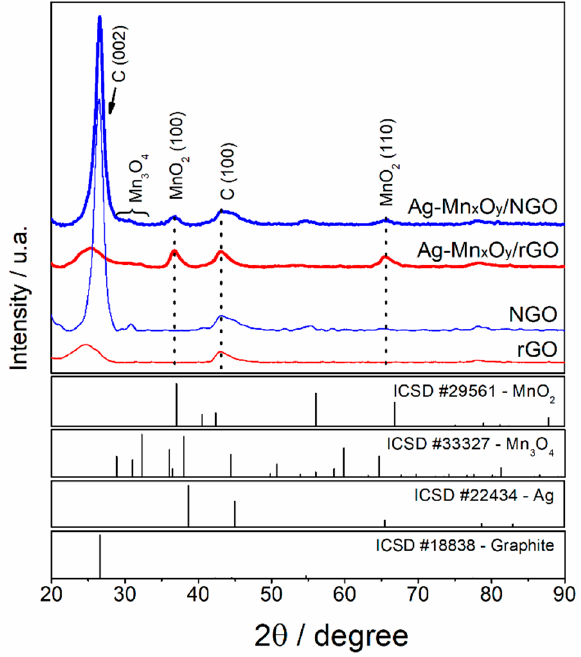
Figure 1. XRD patterns of rGO, NGO, Ag-Mn x O y /rGO, and Ag-Mn x O y /NGO with MnO 2 , Mn 3 O 4 , Ag, and graphite standard patterns from ICSD for comparison.